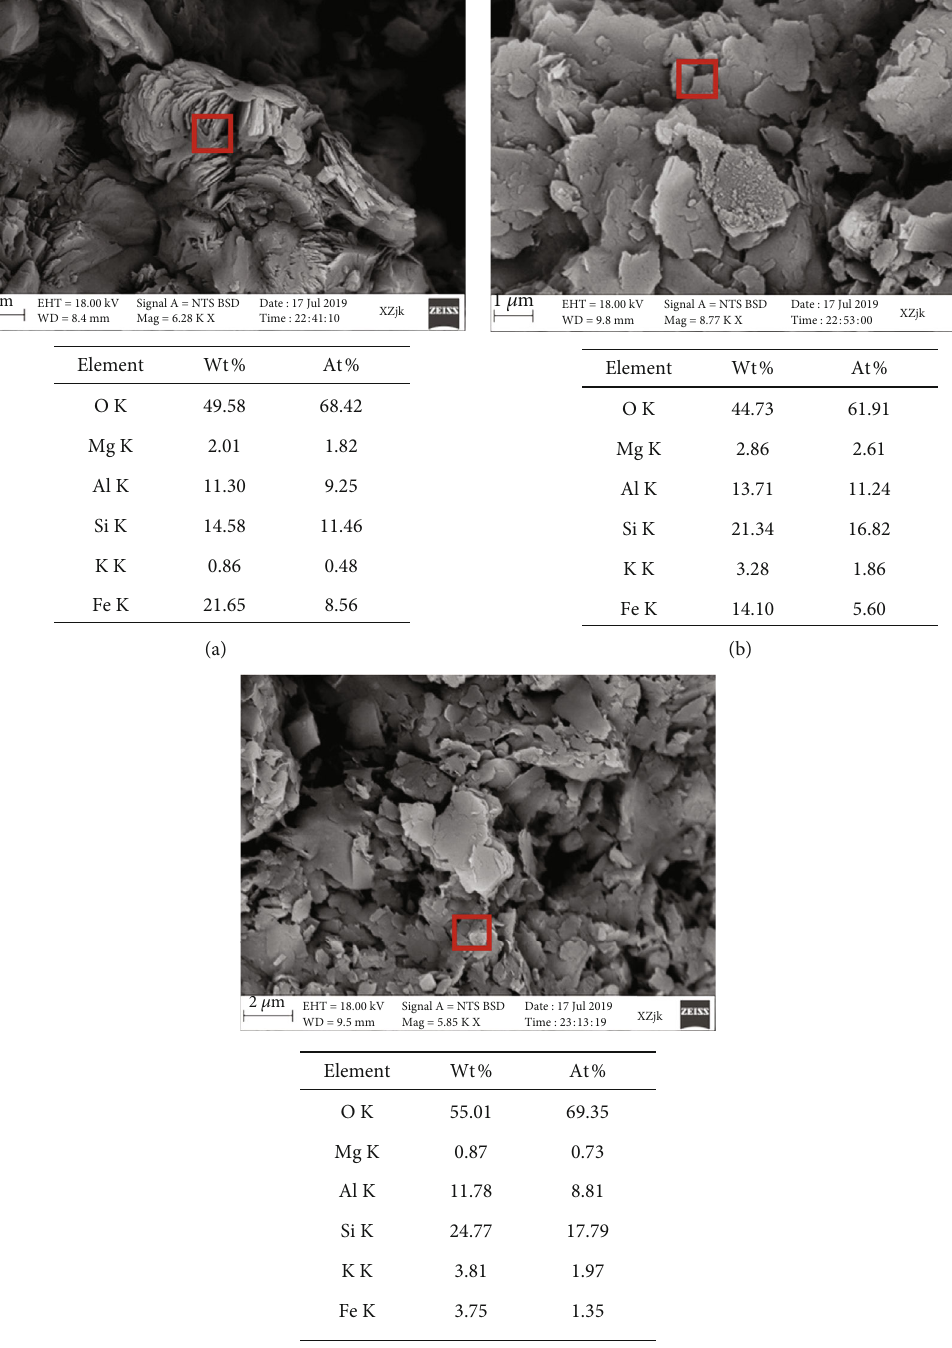
Figure 9: Microstructures of fracture-surface primary clay minerals in sandy mudrock before and after the experiment. (a) Primary chlorite mineral crystals (before the experiment). (b) Corroded chlorite crystals (after the experiment). (c) Corroded illite crystals (after the